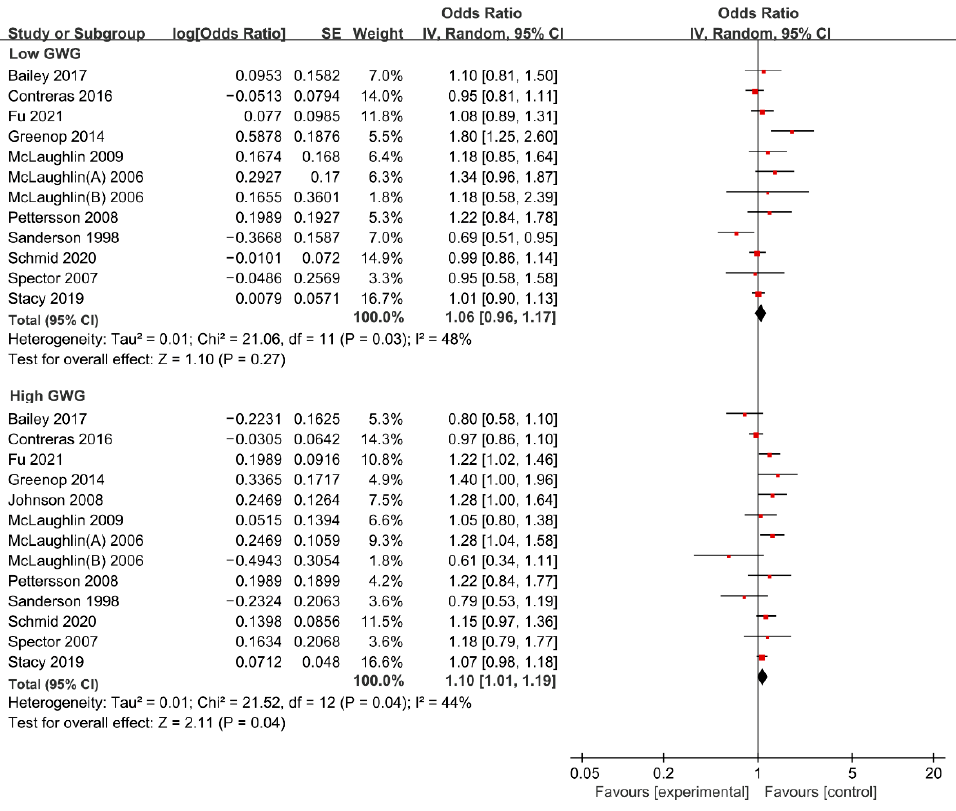
Figure 3. Forest plot of the association between maternal GWG and the risk of total cancer in off-